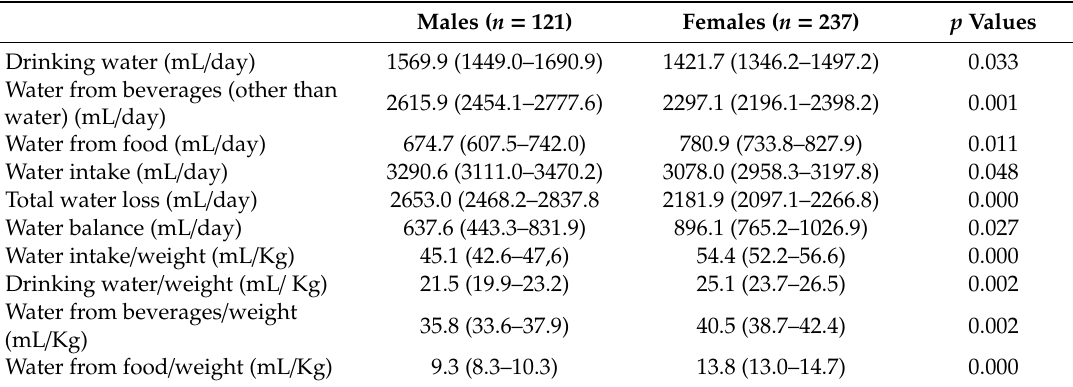
Table 2. Water intake from all sources, water elimination, water balance, and water intake from all sources normalized by body weight, obtained by the hydration status questionnaire and sorted by